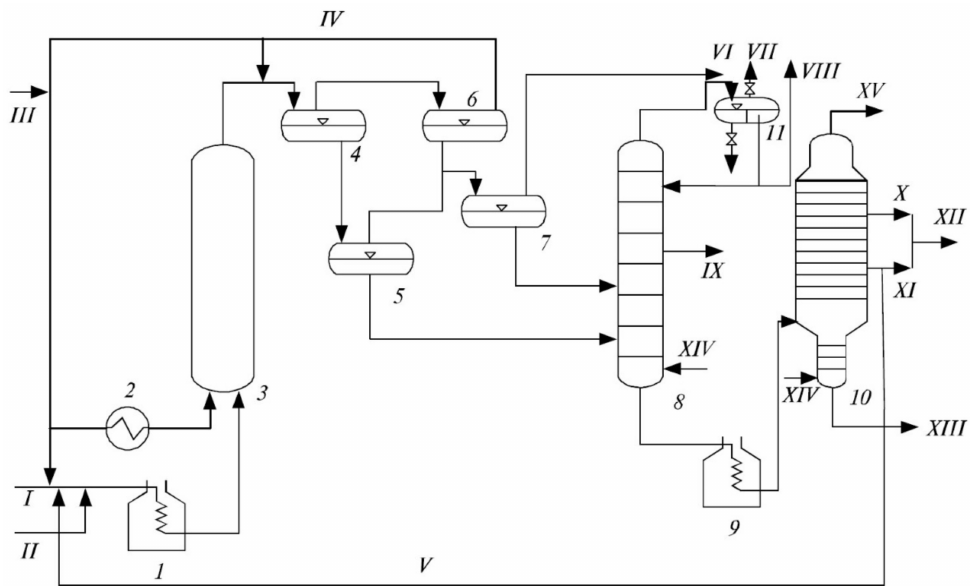
Figure 4. The flow chart of Uniflex with a moving slurry catalyst. 1, 9—furnaces; 2—vapor heater; 3—reactor; 4, 5—hot separators of low and high pressure; 6, 7—cold separators of low and high pressure; 8—distillation column; 10—vacuum column; 11—tank; I—feed; II—catalyst; III—hydrogen; IV—recycling hydrogen-rich gas; V—recycling heavy vacuum gas oil; VI—hydrogen-rich gas to treatment from H 2 S; VII—hydrocarbon gas; VIII—naphtha; IX—diesel fraction; X—light vacuum gas oil; XI—heavy vacuum gas oil; XII—vacuum gas oil; XIII—catalytic pitch; XIV—steam; XV—vacuum column